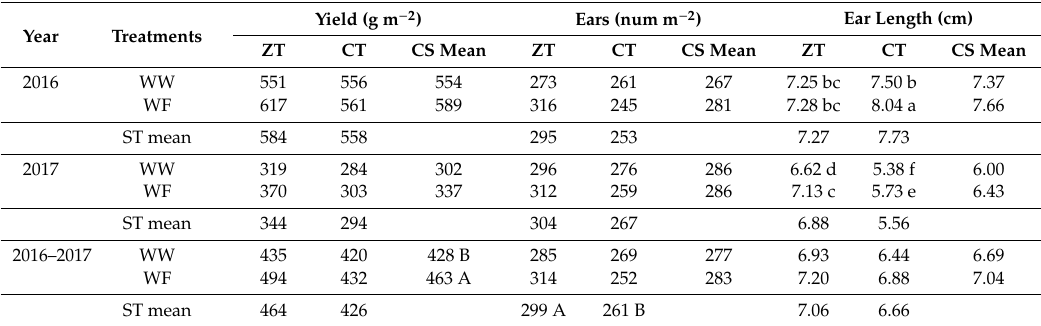
Table 4. Yield (g m − 2 ), number of ears per square meter (ears, num m − 2 ), and ear length (cm) as recorded at harvest in the 2016 and 2017 cropping seasons. Means followed by di ff erent letters (upper case letters: main e ff ects; lower case letters: e ff ects of interaction) significantly di ff er according